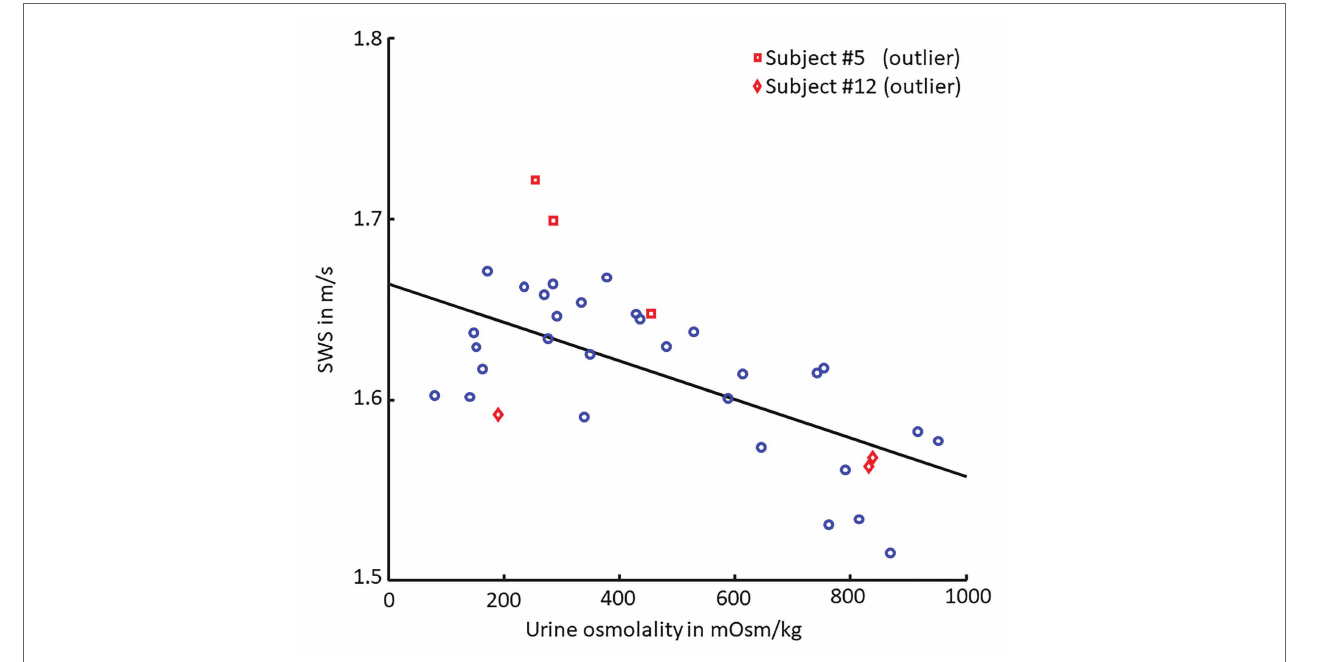
FIGURE 4 | Scatter plot of SWS vs. urine osmolality. Pearson’s linear correlation between shear wave speed (SWS) and urine osmolality (30 values each, p < 0.001, r = − 0.68). Linear regression is shown as black line. Volunteers #5 ( □ , red) and #12 (◊, red) were excluded from correlation analysis as they failed to comply with the fasting